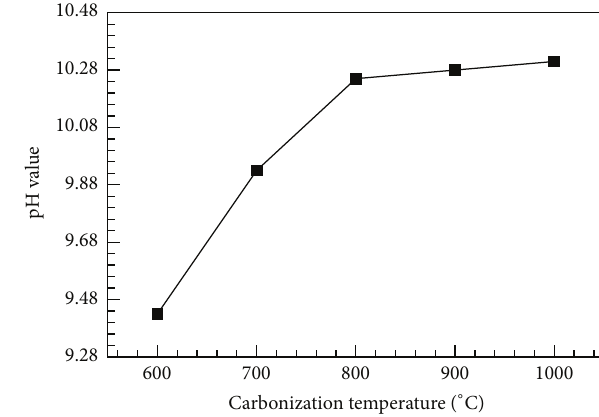
Figure 6: pH value versus carbonization temperature.